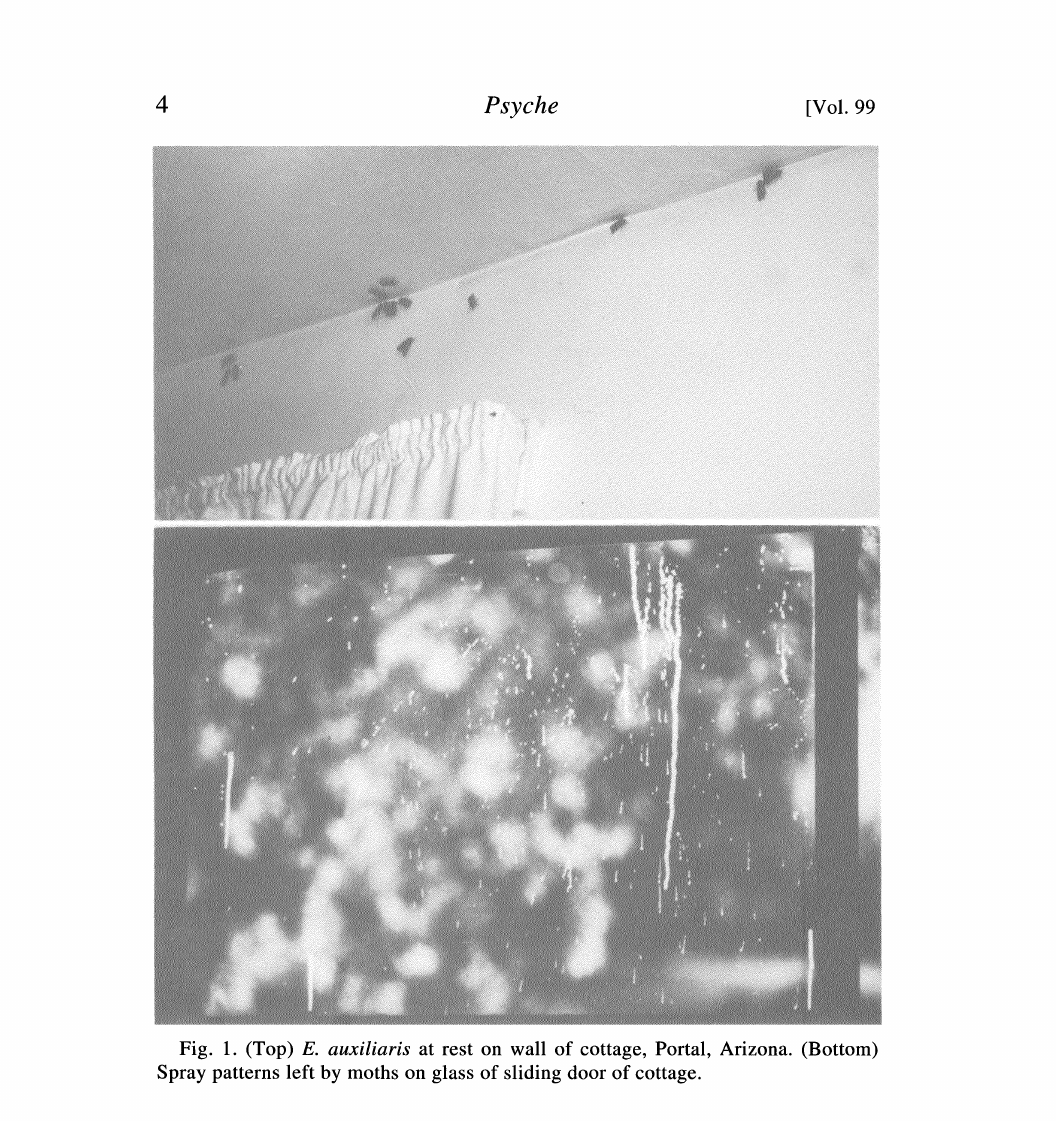
Fig. 1. (Top) E. auxiliaris at rest on wall of cottage, Portal, Arizona. (Bottom) Spray patterns left by moths on glass of sliding door of